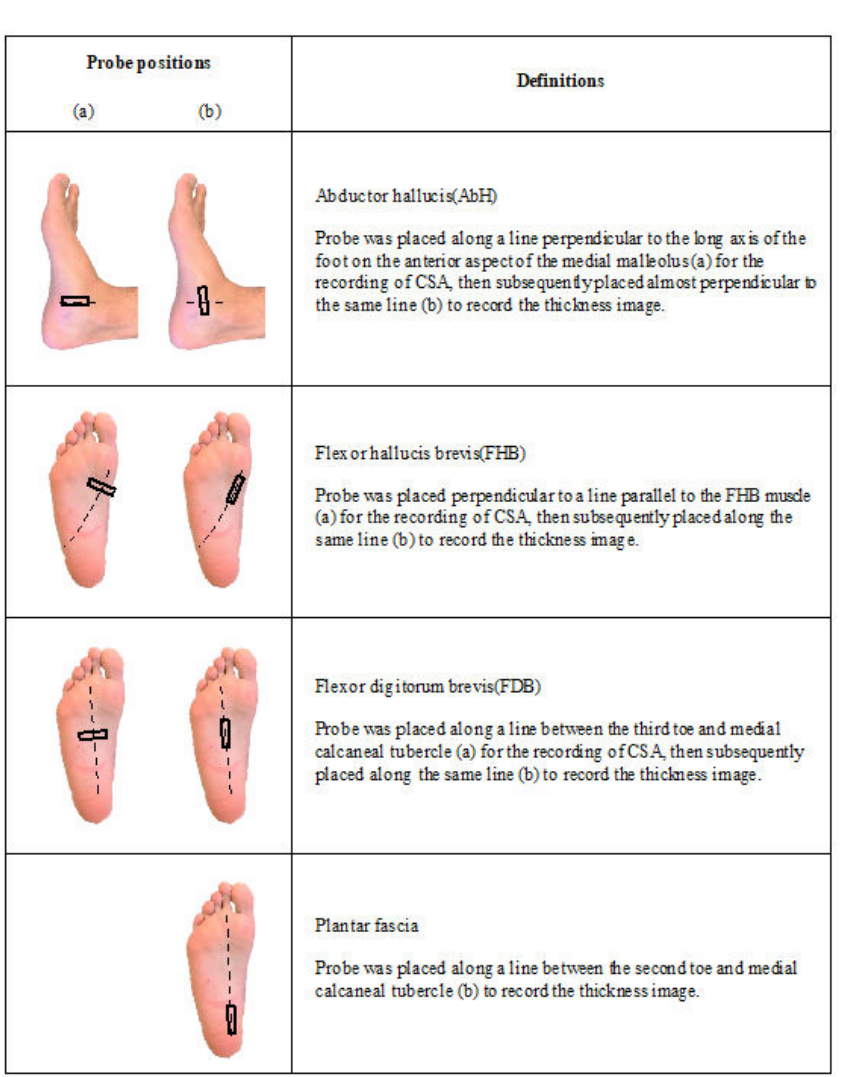
Figure 1. The probe’s position in the assessment of selected tissue thickness and CSA. Abbreviation: AbH, abductor hallucis; FHB, flexor hallucis brevis; FDB, flexor digitorum